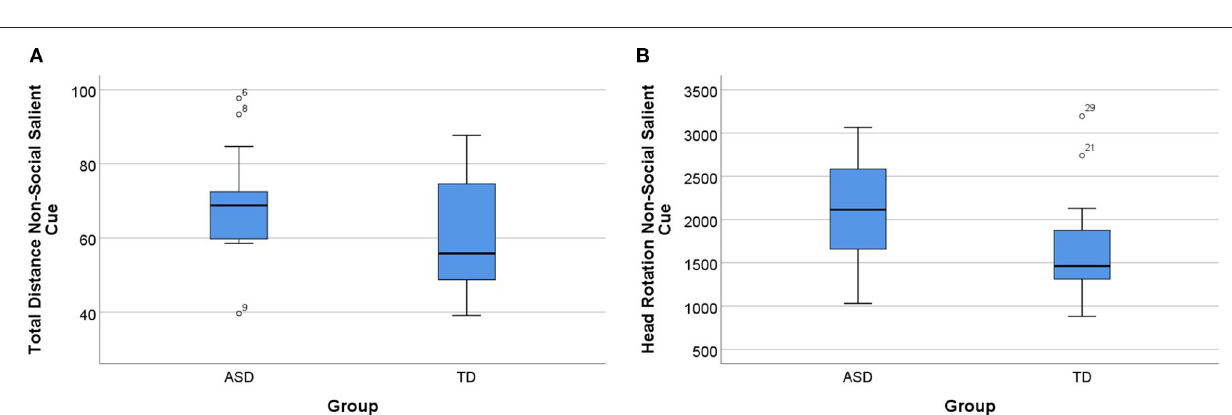
FIGURE 6 | Group differences in the non-social salient cue condition. (A) Total distance for ASD and TD groups for the non-social salient cue condition. (B) Head rotation for ASD and TD groups for the non-social salient cue condition. Boxplots: central mark—median; edges of box − 25th and 75th percentiles; whiskers—most extreme data points (minimum and maximum). ASD, autism spectrum disorder group; TD, typical neurodevelopment